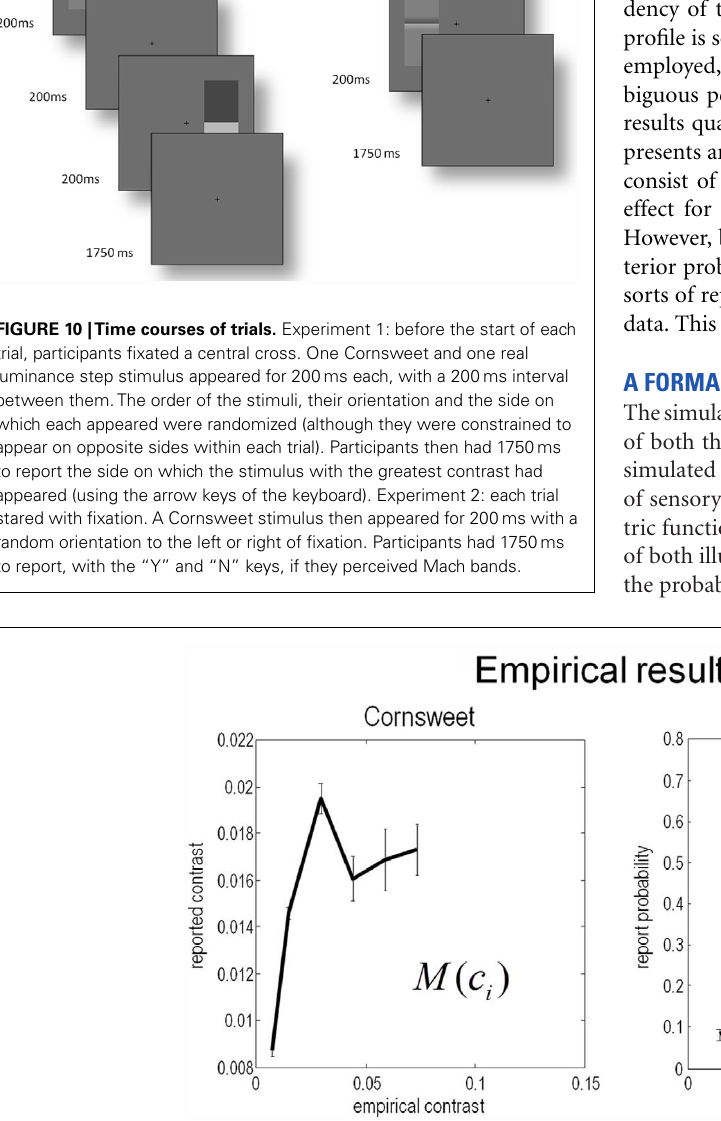
FIGURE 11 | experimental results. This figure shows the results of the empirical psychophysical study for the Cornsweet illusion (left panel) and the Mach band illusion (Right panel). Both report the average effect over subjects and the SE (bars).The Cornsweet illusion is measured in terms of the subjective contrast level (quantified in terms of subjective equivalence using psychometric functions).The Mach band illusion is